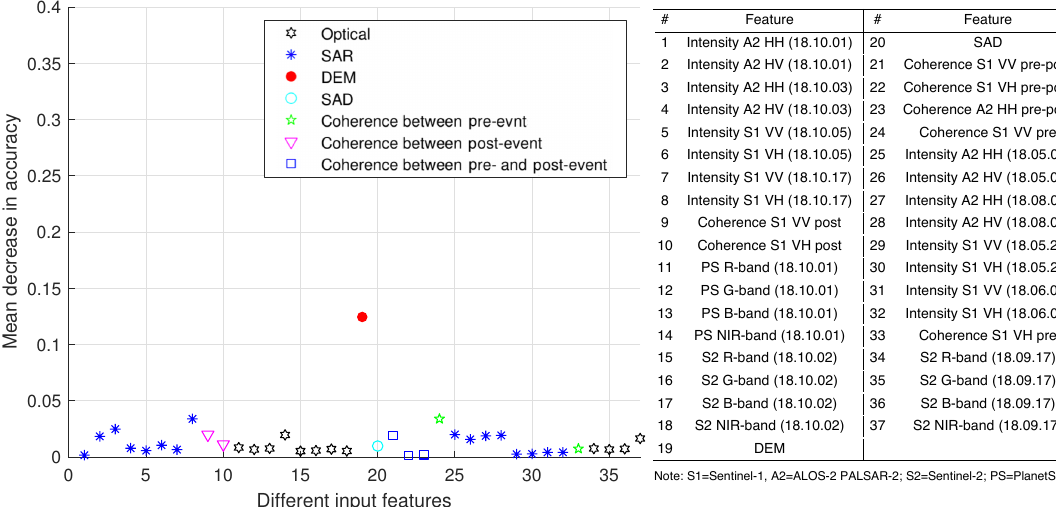
Figure 5. Importance of the 37 input features provided by different sources.